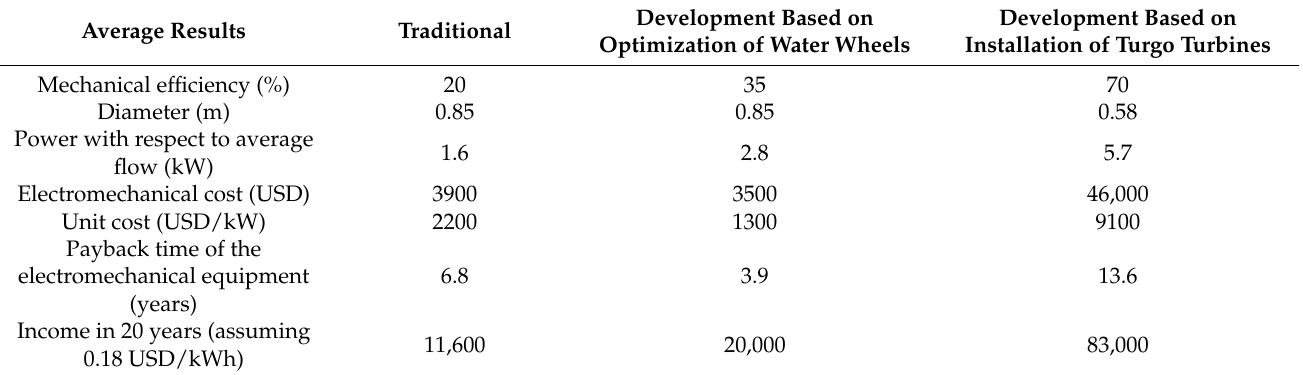
Table 1. An economical comparison of traditional and developed water mills (adapted from